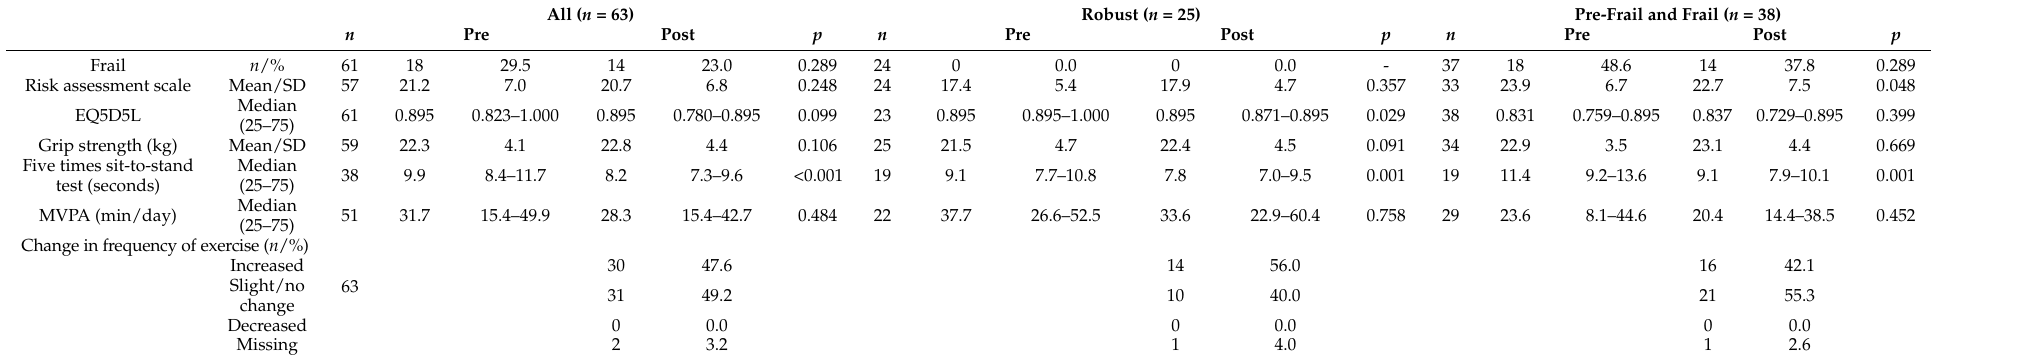
Table 5. Changes in health indicators before and after the